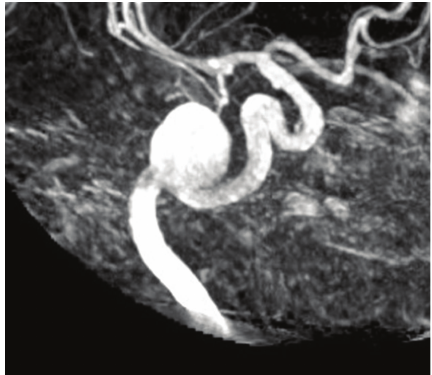
Figure 3: 3D DSA of a giant, left, petrous ICA aneurysm. Stent- assisted coiling was performed on this